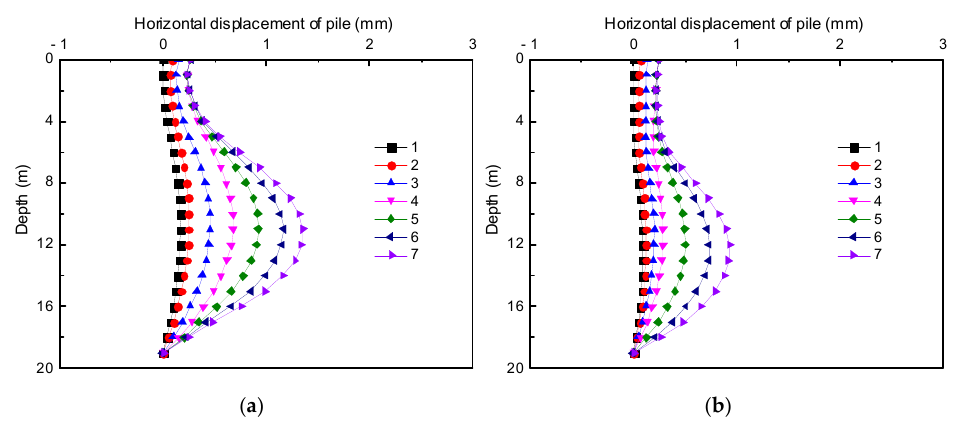
Figure 7. Displacement: ( a ) No. 1 pile; ( b ) No. 2 pile.